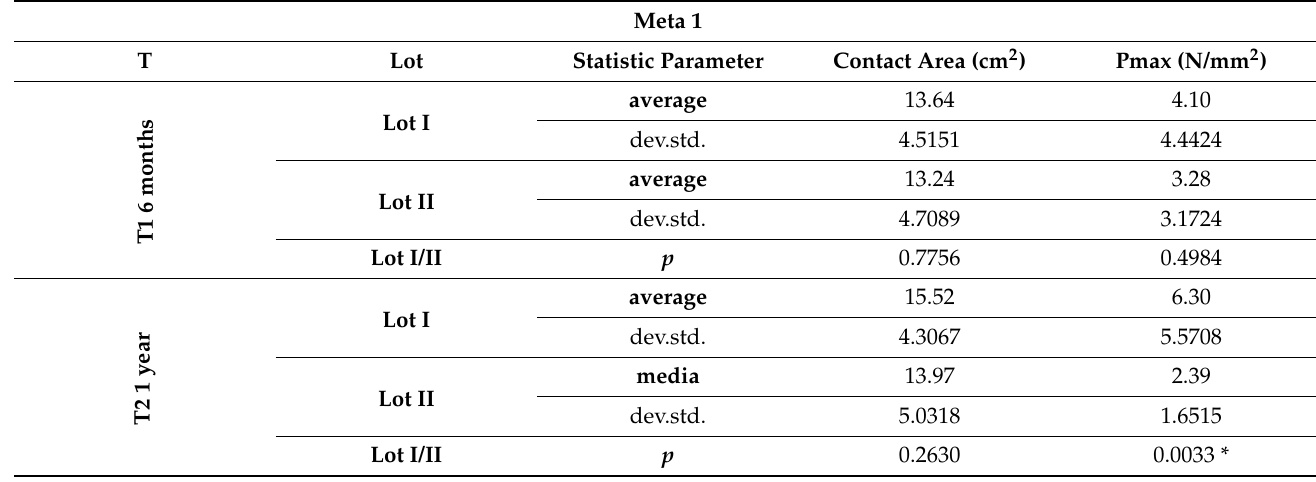
Table 6. Average values Meta 1, 6 months and 1 year. Meta 1